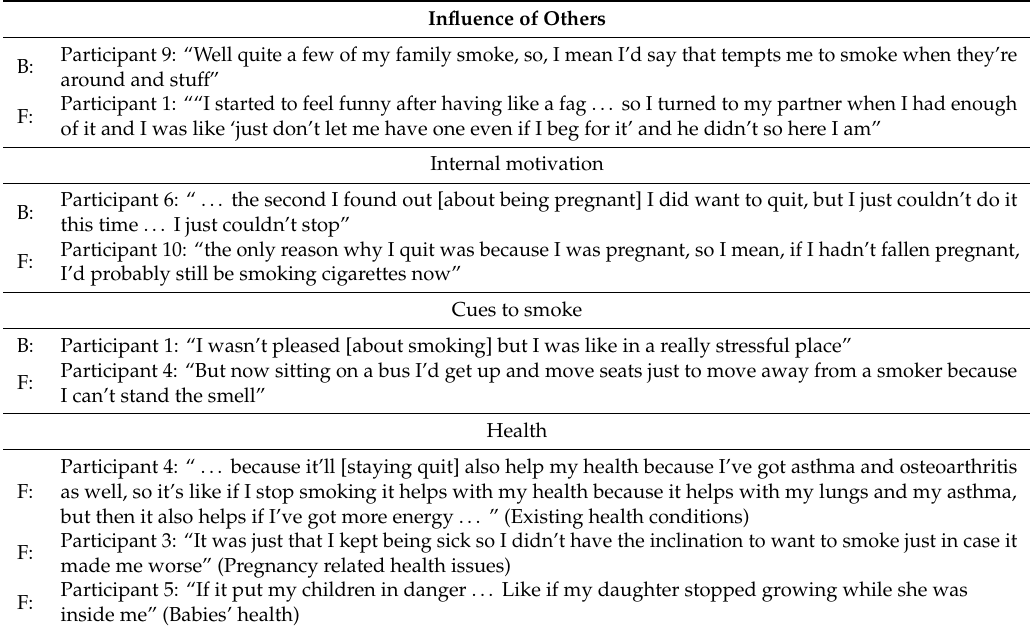
Table 2. Examples of barriers and facilitators experienced by